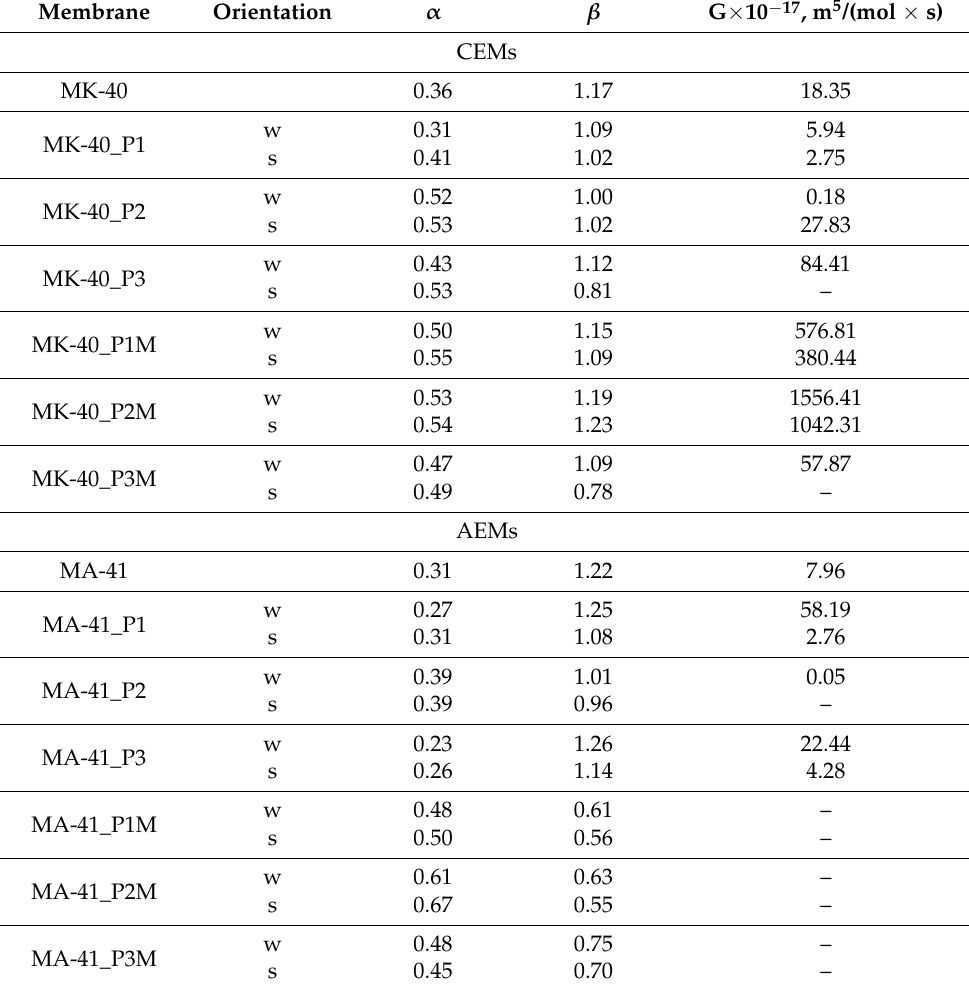
Table 2. The transport-structural parameters of initial, single, and bilayer profiled membranes.